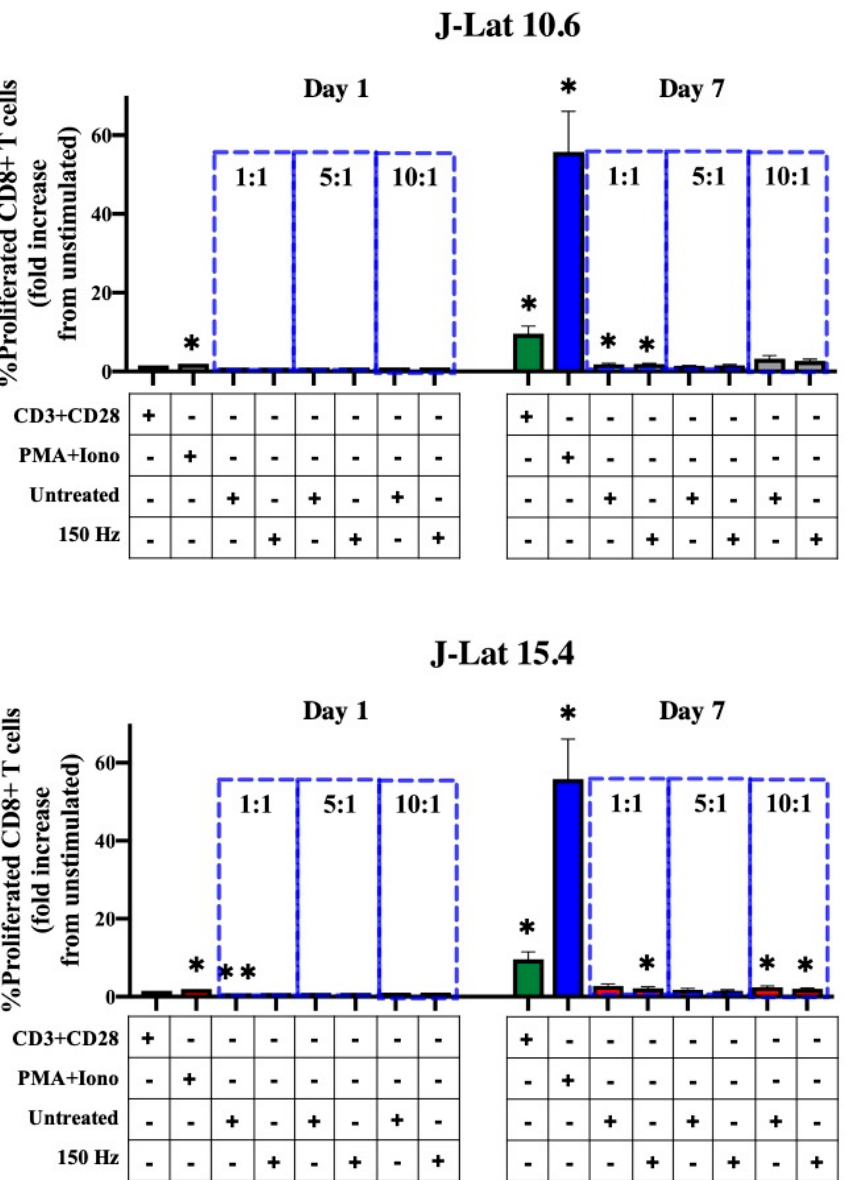
Figure 4. CD8+ T-lymphocyte proliferation is not stimulated in co-culture with NTP-exposed J-Lat cells. Summary of the percent proliferated CD8+ T lymphocytes (CTFRlo) demonstrating no statistically significant increase in proliferated CD8+ T lymphocytes co-cultured with NTP-exposed cells compared to those co-cultured with untreated J-Lat controls at any of the effector:target (E:T) ratios (1:1, 5:1, or 10:1). Gray and red bars indicate J-Lat clones 10.6 and 15.4, respectively. CD8+ T lymphocytes treated with an anti-CD3 and anti-CD28 antibody cocktail (CD3 + CD28; green bars) or a PMA and ionomycin cocktail (PMA + Iono; blue bars) served as positive controls for proliferation. Data are presented as mean ± SEM from three independent experiments ( n = 3 donors), with three replicates per condition. Statistical significance was calculated according to the unstimulated CD8+ T-lymphocyte control using the one-way Anova with Dunnett’s post-hoc test (* p ≤ 0.05, ** p < 0.01).